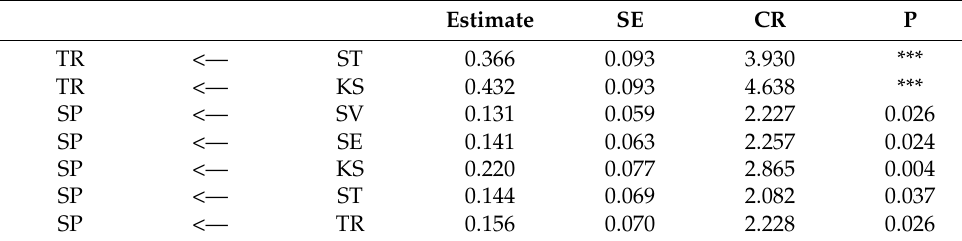
Figure 4. Structure equation model—the path diagram. Table 8 highlights the results of the unstandardised regression weights estimations. Table 8. Unstandardised regression weights estimations.